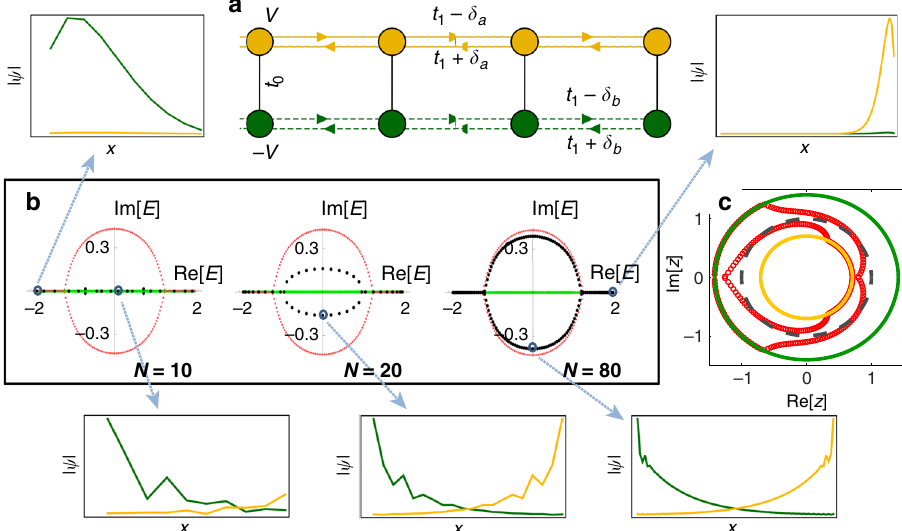
Fig. 2 Critical non-Hermitian skin effect and fi nite-size scaling in the model of two coupled Hatano – Nelson chains. a The two-chain model [Eq. (3)] with hopping asymmetry in chains a , b denoted by δ a / b , and on-site energy offset ± V . A small inter-chain t 0 can cause signi fi cant coupling when δ a ≠ δ b . b Open- boundary spectra (black dots) and eigenstate pro fi les (insets) with N = 10, 20, and 80 unit cells and the coupling parameter t 0 = 0.01, showing very different spectral behavior at different system sizes N . At small N ≈ 10, coupling effects are negligible, with the spectrum coinciding with the real-value open-boundary E ∞ spectrum (green) in the decoupled thermodynamic limit. As N increases, the spectrum gradually approaches the open-boundary E ∞ spectrum (red) for the coupled thermodynamic limit, with hybridization becoming sharper. c The generalized Brillouin zones of the two chains in the decoupled limit (yellow and green), and that of the two bands with t 0 = 0.01 (red circles, numerically obtained at N = 80). The Brillouin zone with ∣ z ∣ = 1 is given by the gray dash circle. Other parameters are t 1 = 0.75, δ a = − δ b = 0.25, and V =